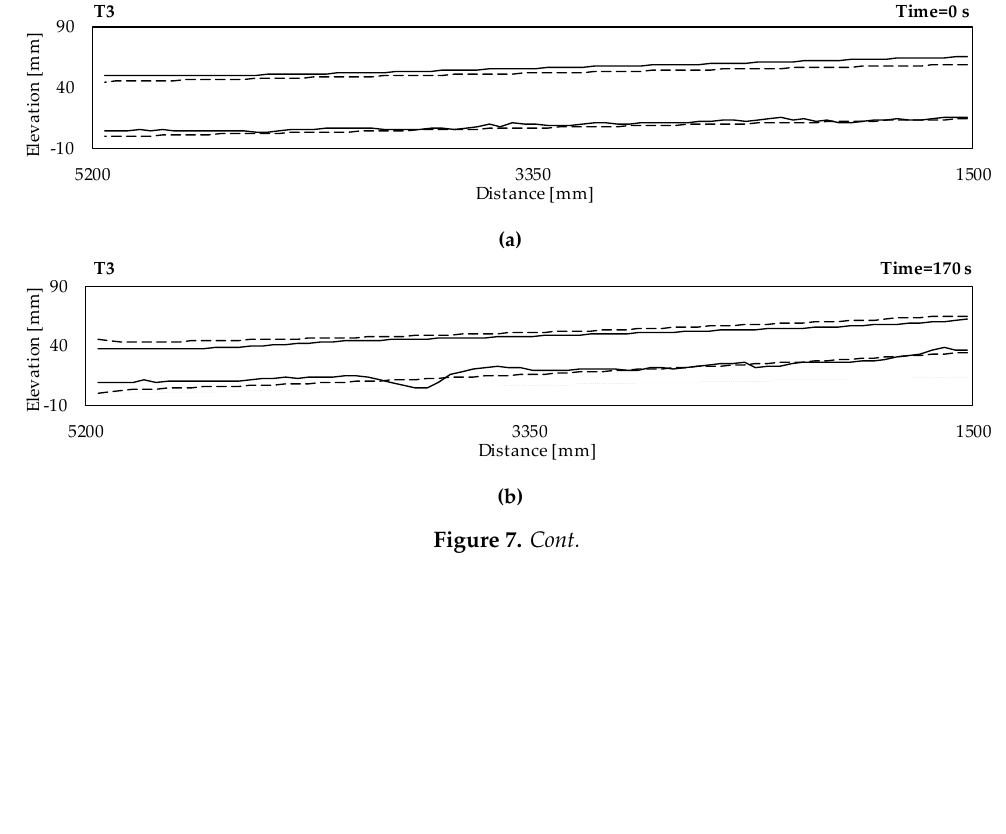
(d) Figure 7. Longitudinal bed and water profiles for the experiment T3 obtained experimentally (continuous) and numerically (dashed) at (a) 0 s, (b) 170 s, (c) 340 s, and (d) 680 s. The horizontal axis represents the stream-wise distance from the inlet, whereas the vertical coordinates were measured with respect to the initial bed surface elevation at the channel outlet. The longitudinal bed profile at 0 s is represented by the gray line. Flow is from right to left. (a) (b)